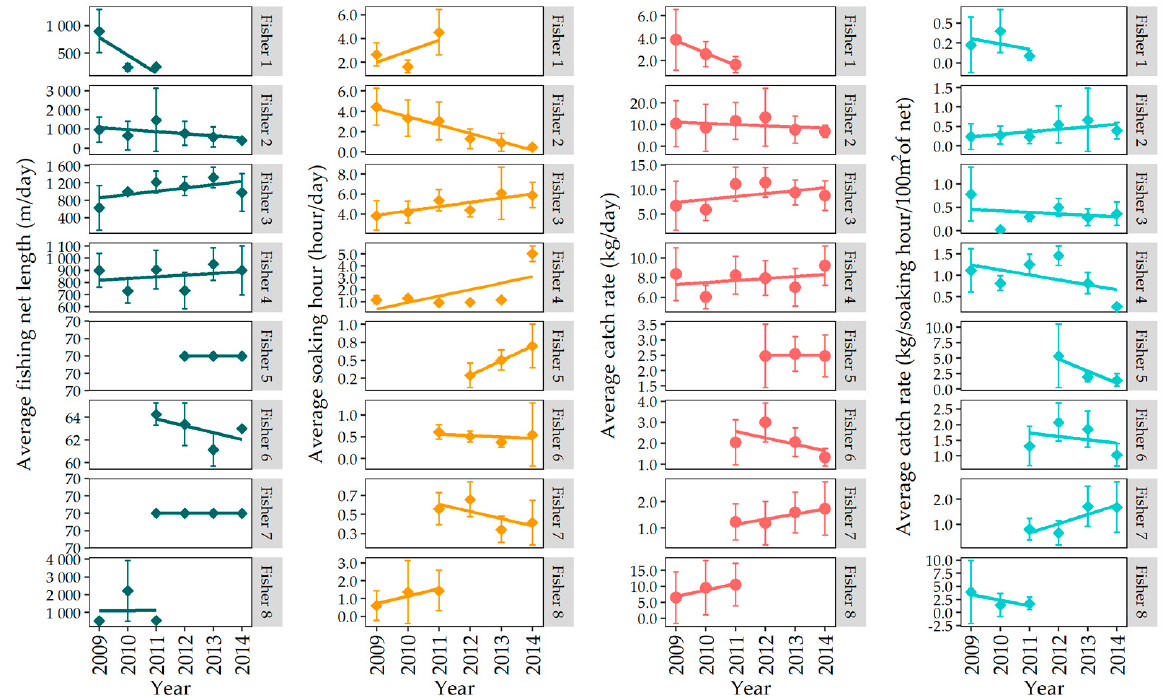
Figure 5. Annual variation of gill-net length used for fishing, fishing hour, catch rates (expressed as kg/day and kg/soak hour/100 m 2 gill-net area) together with a standard deviation of eight fishers under the fisher catch monitoring program of RIA2/MRC from 2009 to 2014.